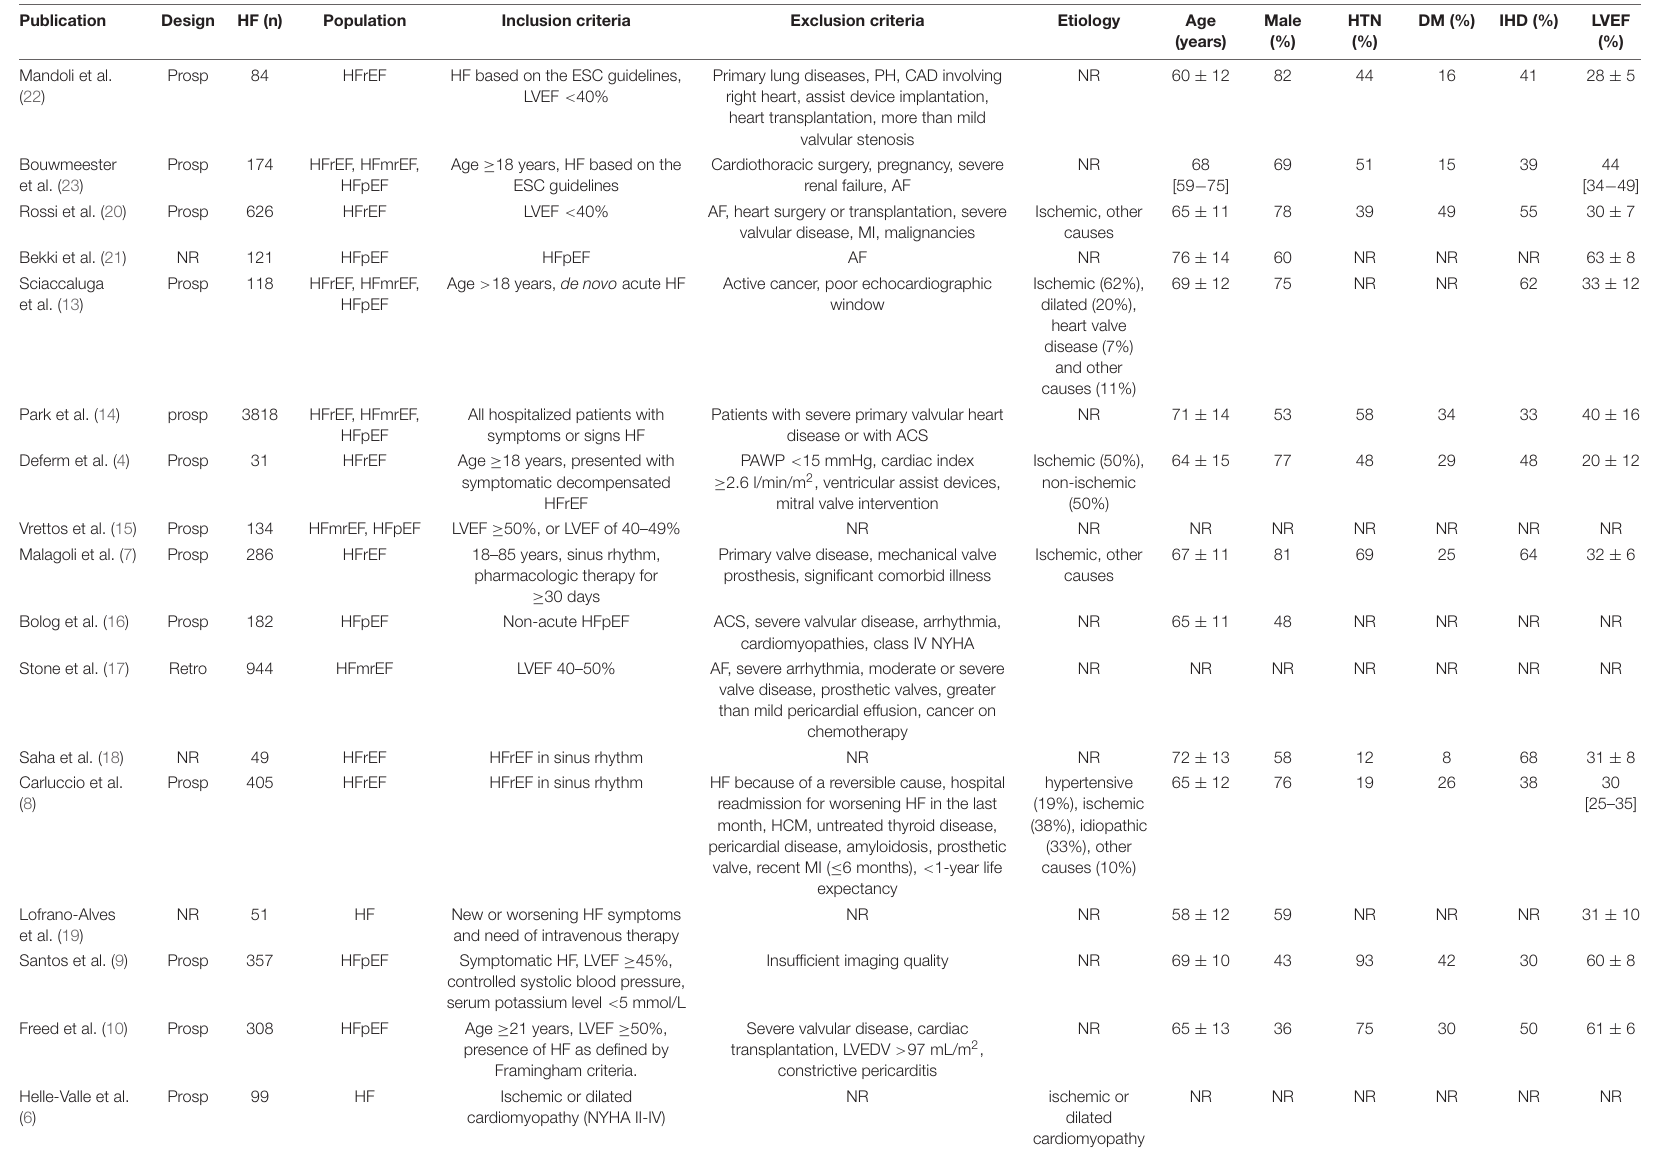
TABLE 1 | Summary of study design and patient